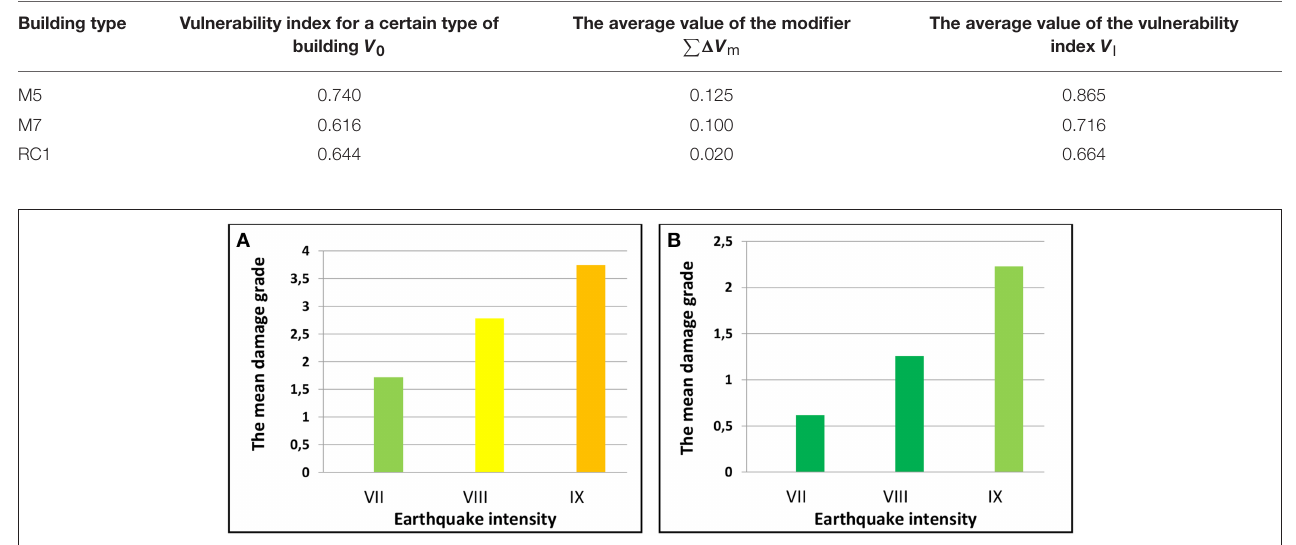
TABLE 2 | Average Values of the Vulnerability Index.